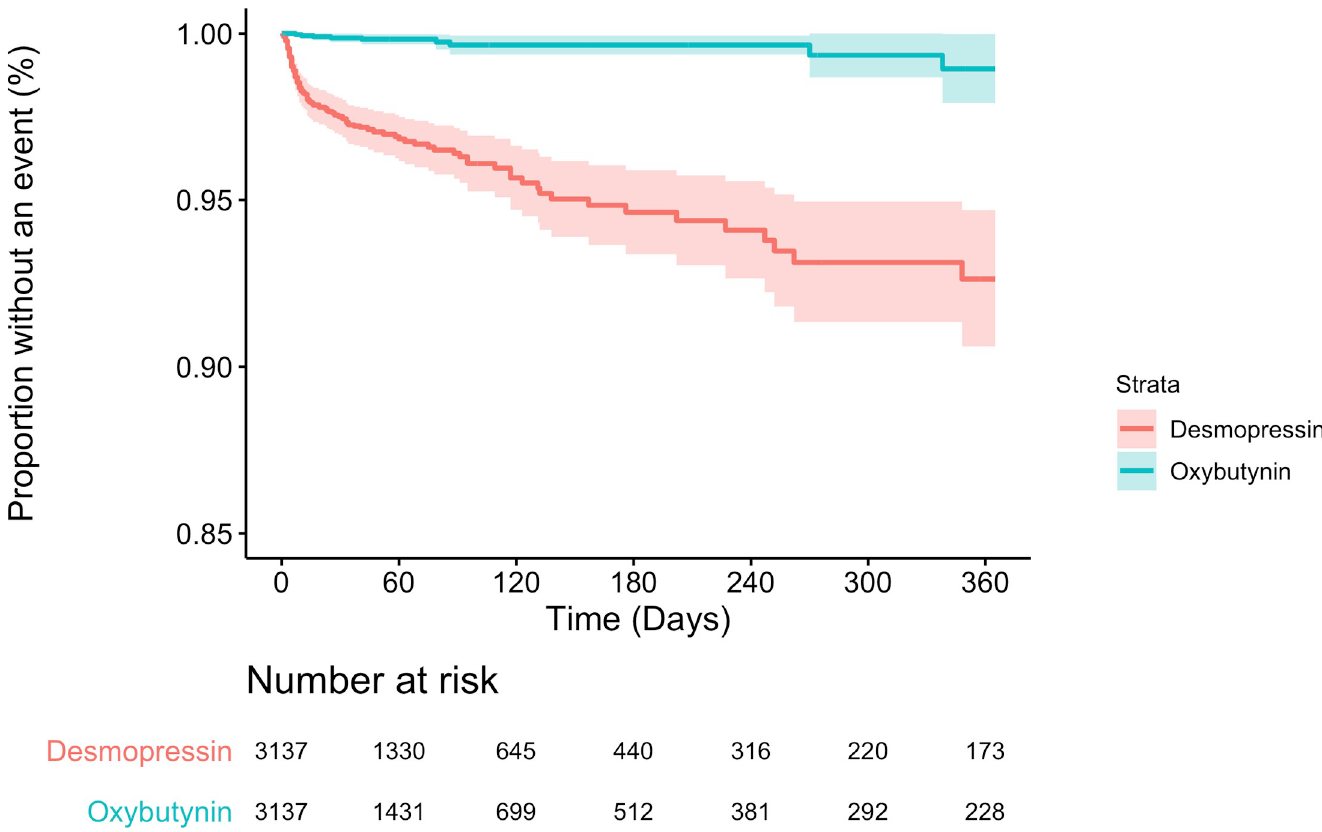
Fig 1. Kaplan–Meier curve for PS-matched rate of hyponatremia. PS, propensity score.